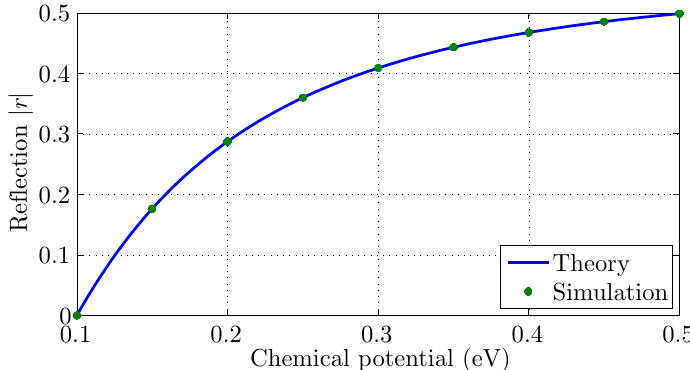
Figure 4. Reflection coefficient of a graphene surface wave due to chemical potential